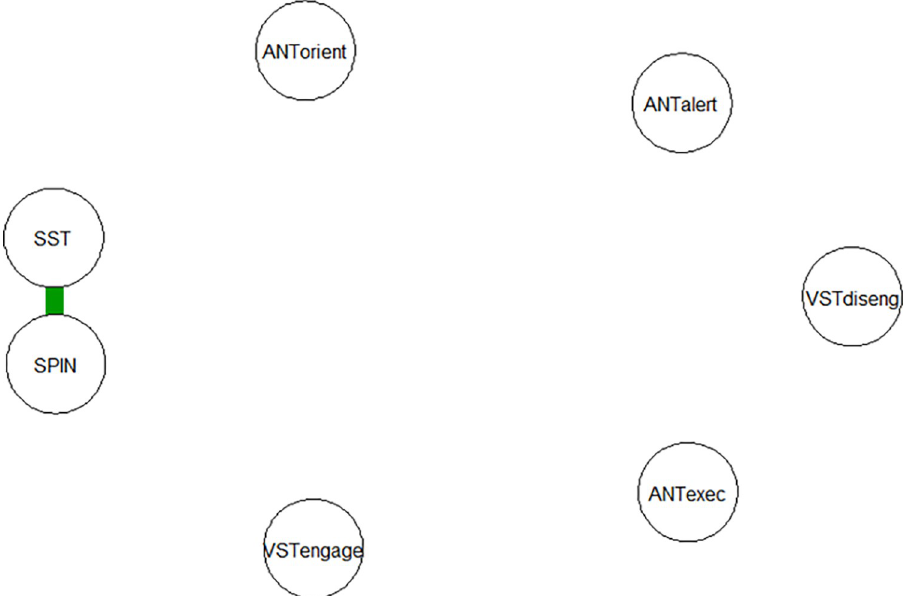
Fig 3. Diagram of regularized network with tuning parameter set to γ = 0.5. ANT: Alert, Orient, Execut = Attention Network Test: Alerting, Orienting, Executive function. VST: Diseng, Engage = Visual Search Task: disengagement, engagement; SST = Scrambled Sentence Task; SPIN = Social Phobia